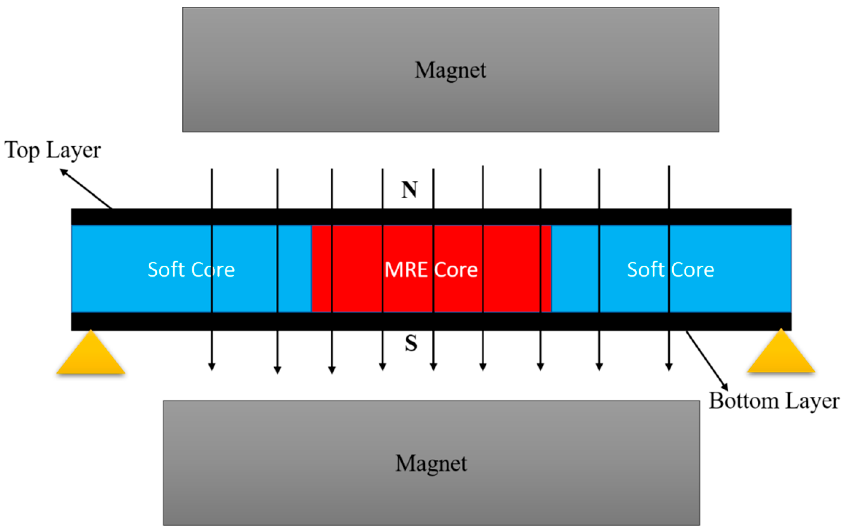
Figure 21. Representation of partially treated MRE sandwich beam.